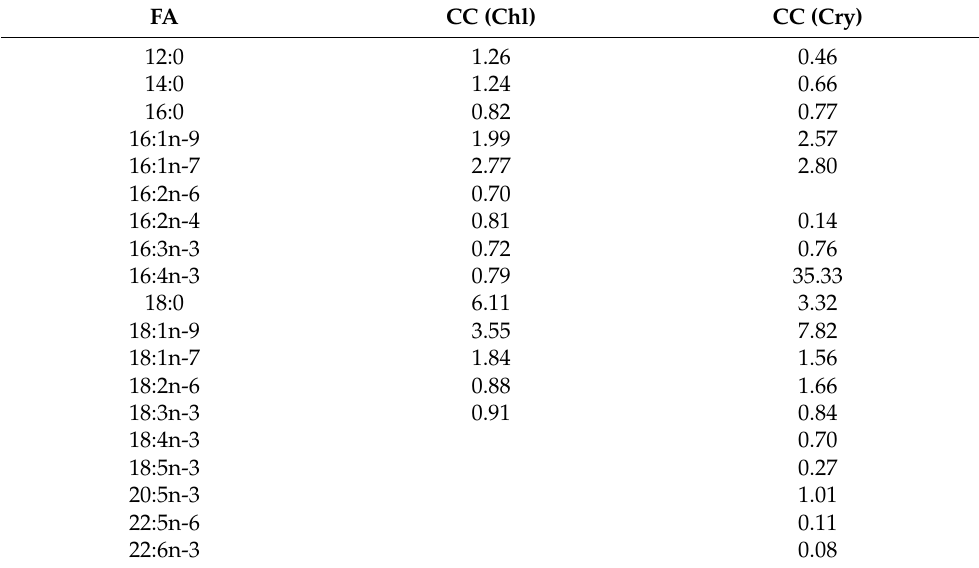
Table 5. Calibration coefficients ( CC ) for the QFASA model for Chlorella (Chl) and Cryptomonas (Cry) calculated from data presented in Figures 2 and 3 (see Methods for details).